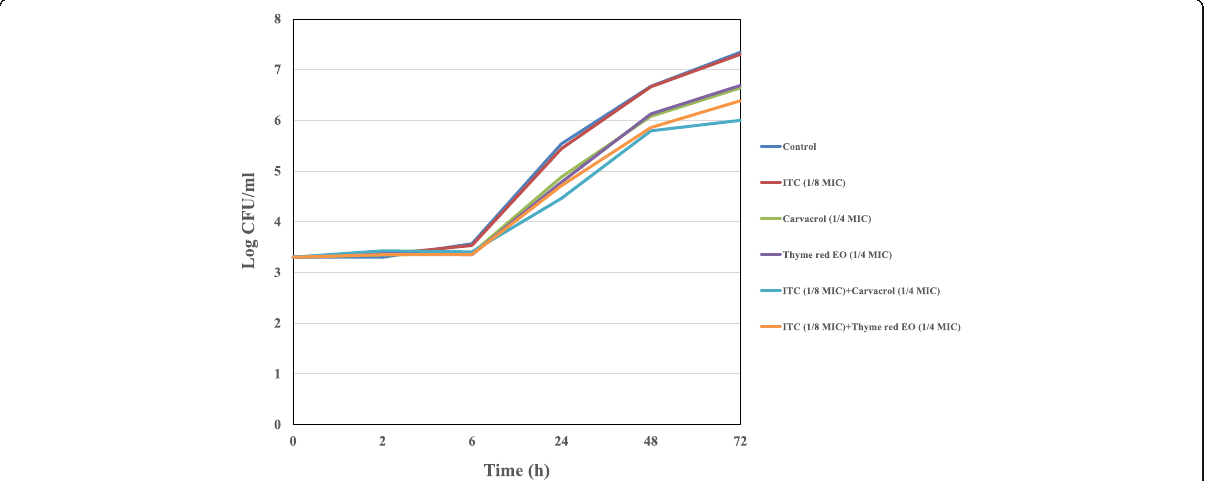
Fig. 5 Time-kill curve of ITC, thyme red EO and carvacrol alone and in combination against C.neoformans ADS 006 (azole not-susceptible